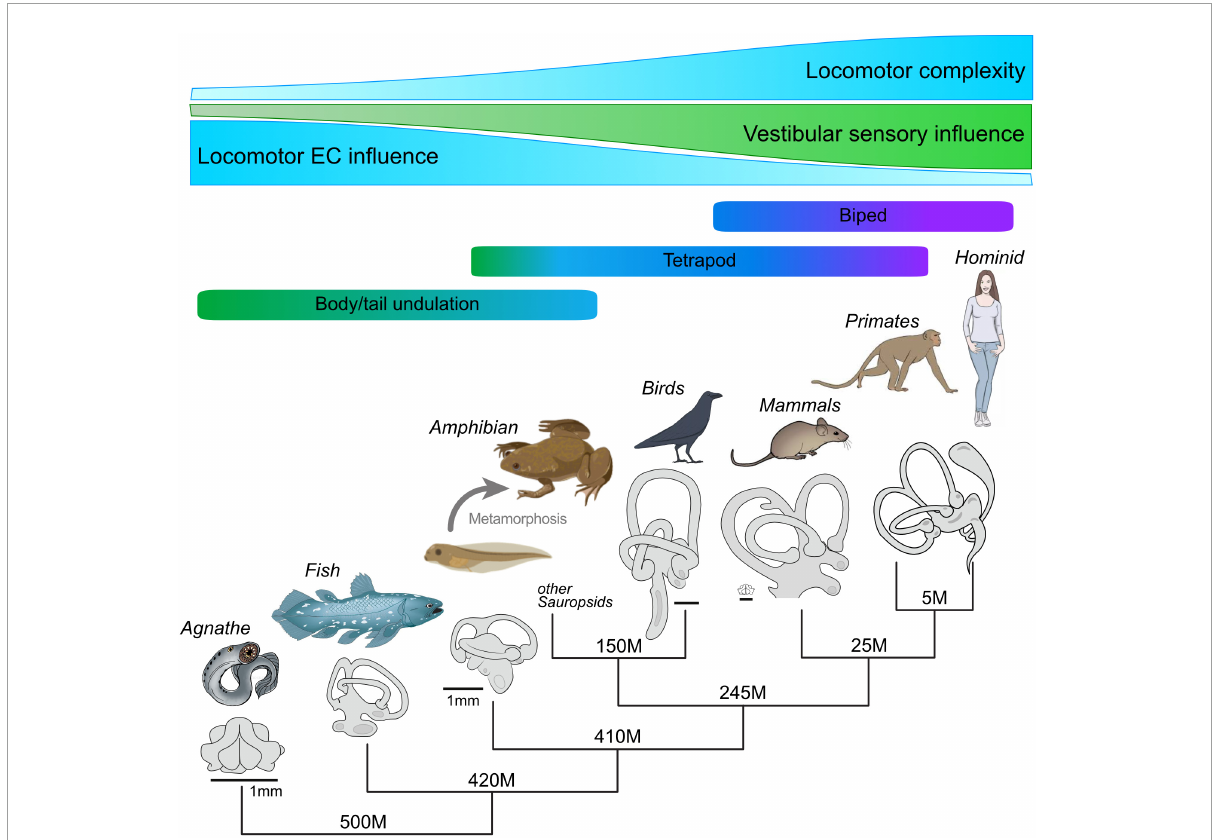
FIGURE6 Hypothetical evolutionary development of locomotor complexity in vertebrates, the accompanying increase in morphological complexity and the role played by vestibular sensory signaling, and the resultant gradual decline in locomotor EC influence in the production of compensatory eye movements. Despite the increasing capability of inner ear endorgans for motion detection and sensory-motor transformations, locomotor EC signals appear to have maintained an important role in gaze stabilization, even during bipedal